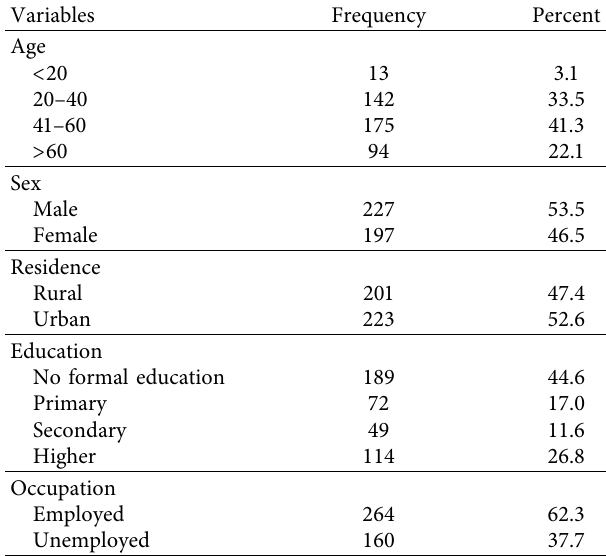
Table 1: Sociodemographic characteristics of patients with renal impairment admitted to medical wards at Amhara region referral hospitals, Amhara Ethiopia, in 2020 ( n � 424).